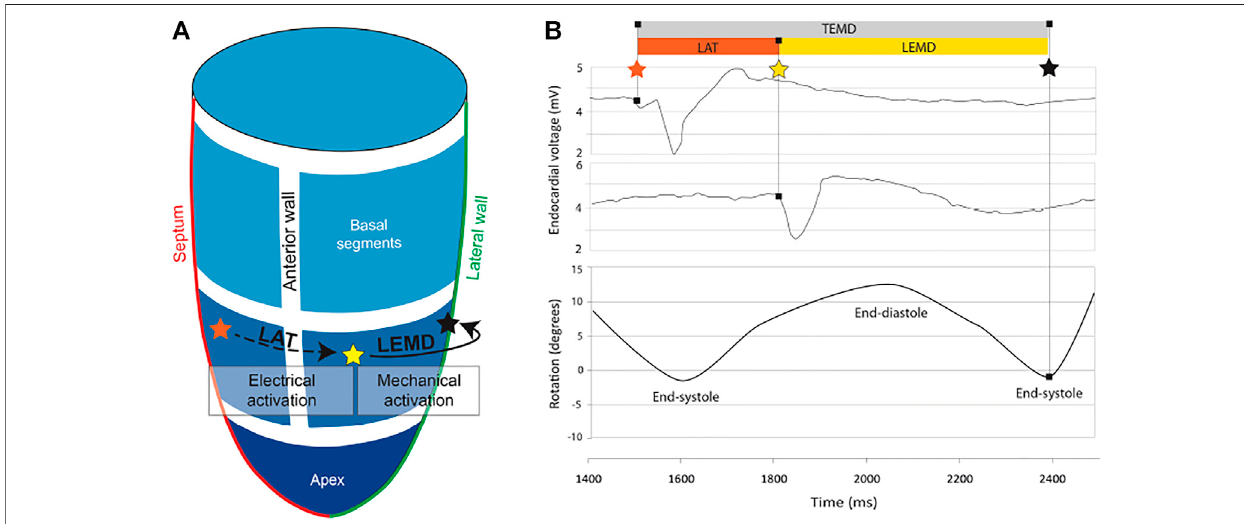
FIGURE 2 | (A) 3D model of the left ventricle showing the relation between local activation time (LAT) and local electromechanical delay. (B) Electromechanical parameters of the left ventricle and how they relate to endocardial voltage and rotation. The orange star indicates the fi rst electrical activation in the LV. The yellow star indicates measured electrical activity at another location in the LV. As the tissue at this position startsto contract, the LV begins to rotate. The time when peak rotation is reached, is symbolized by a black